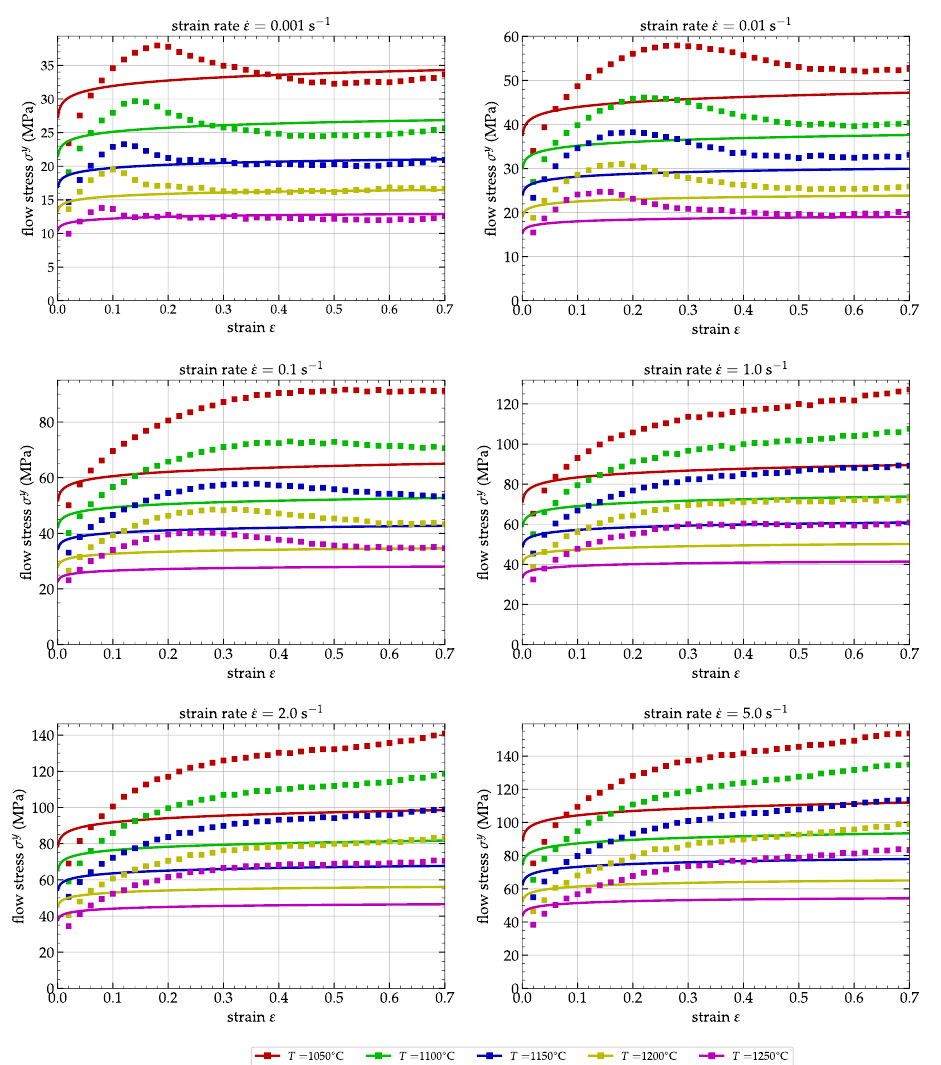
Figure 7. Comparison between the experimental (dots) and predicted (lines) flow stresses σ y by the Modified-Zerilli–Armstrong